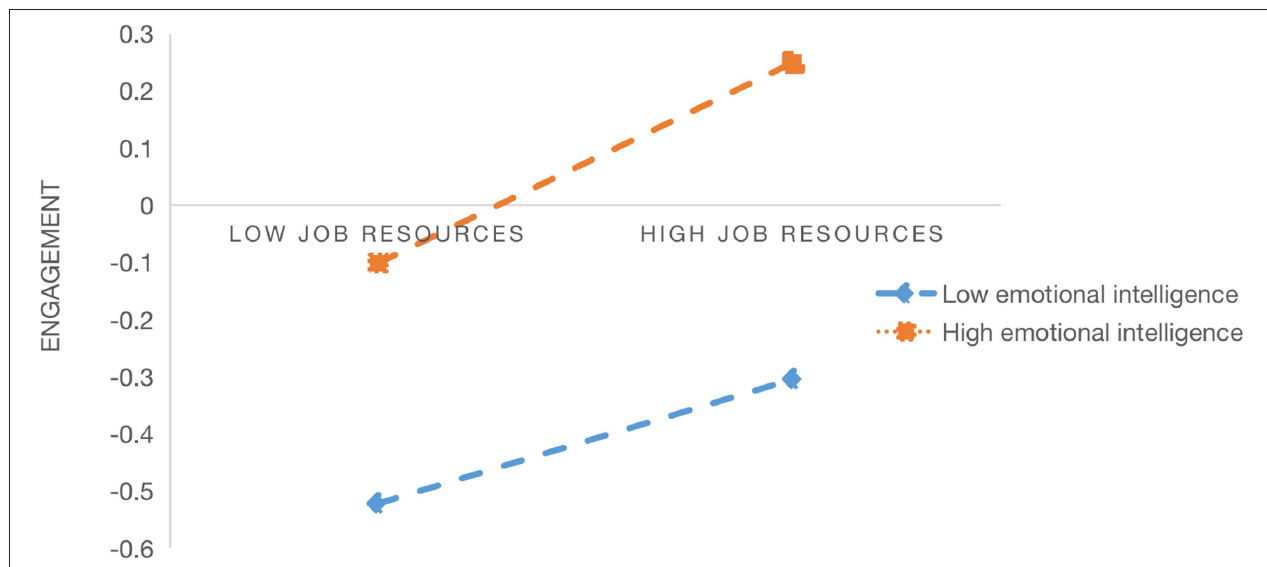
FIGURE 2 | Emotional intelligence as a moderator on the relationship between job resources and work engagement.